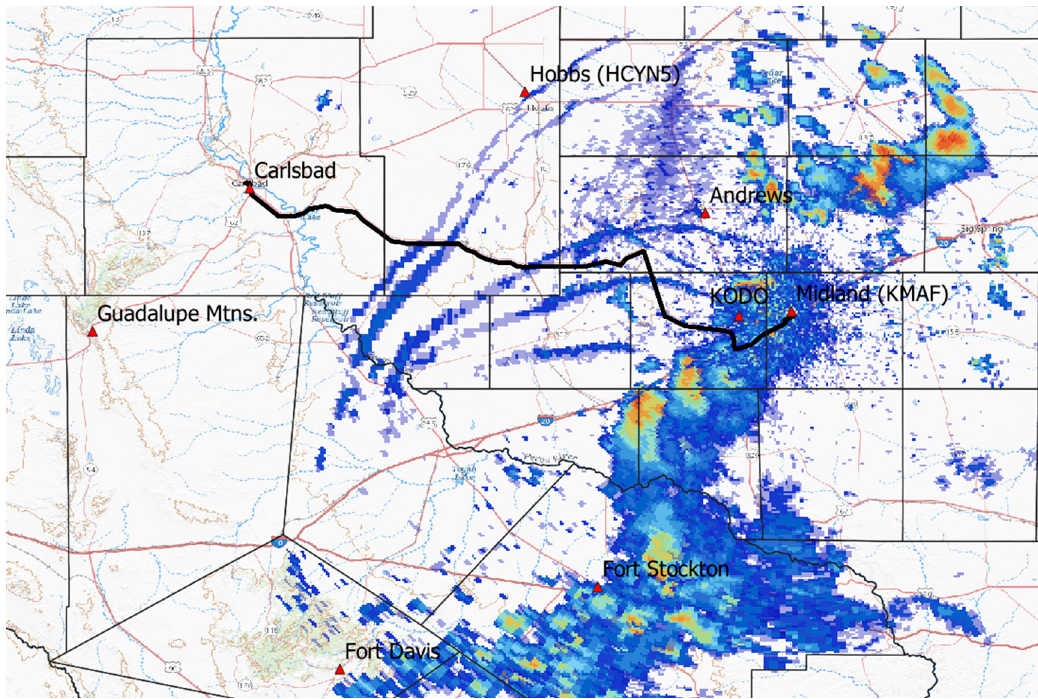
Figure 16. Base reflectivity from the KMAF radar overlaid from 2232, 2300, 2324, 0035, and 0102 UTC. Radar data were unavailable from KMAF before 2227 and between 2324 and 0035 UTC. The dryline during this period was oriented north-south in the vicinity of Andrews.